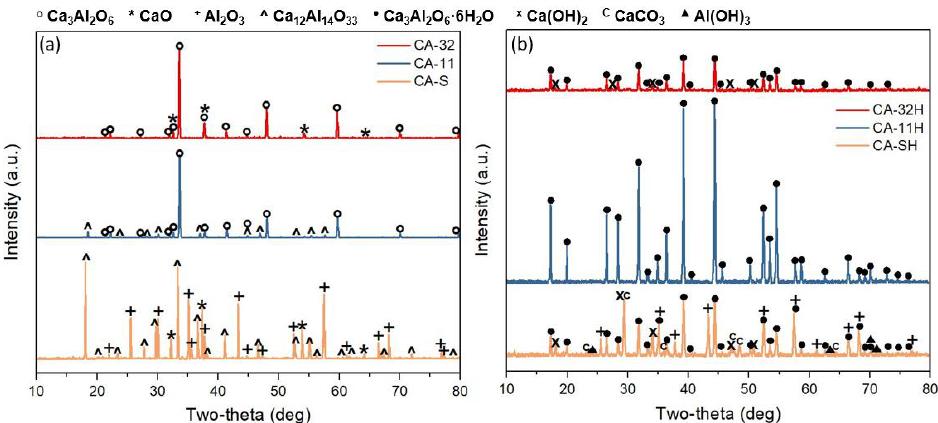
Figure 4. Diffraction patterns after calcination ( a ) and after hydration ( b ) for CA-32/CA-32H (red), CA-11/CA-11H (blue) and CA-S/CA-SH (orange). (JCPDS reference cards: Ca 3 Al 2 O 6 : 38-1429; CaO: 70-4068; Ca 12 Al 14 O 33 : 09-0413; Al 2 O 3 : 34-0440; Ca 3 Al 2 O 6 · 6H 2 O: 24-0217; Al(OH) 3 : 33-0018; Ca(OH) 2 : 44-1481; CaCO 3 : 83-1762).